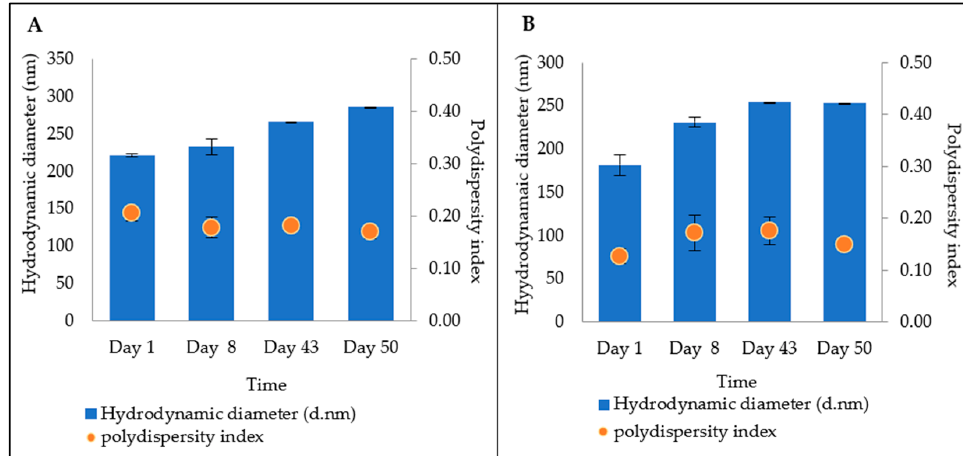
Figure 5. Stability test for particle size distribution over 50 days for Formulation ( A , B ).